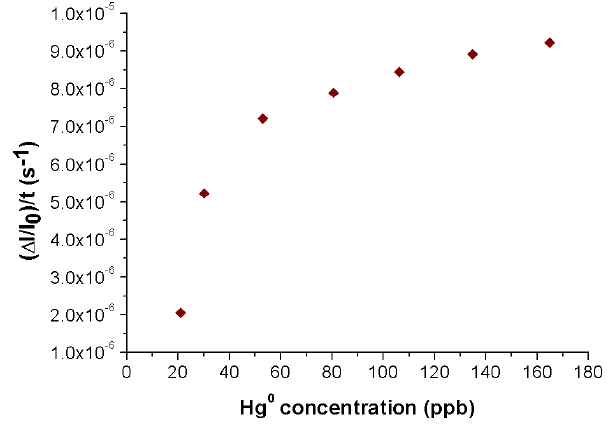
Figure 9. Linear fitting of the normalized sensor response within the first 10min.